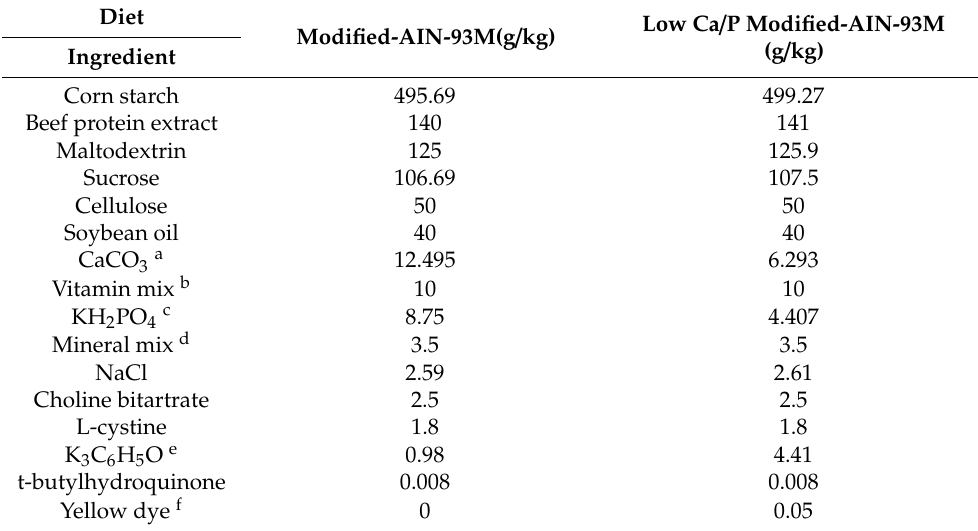
Table 1. Ingredients (g / kg) of the diet pellets used in the animal feeding trial (Reproduced from Burrow et al. [16])